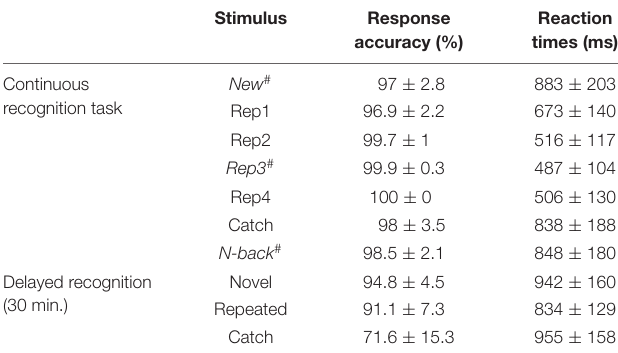
Percentage of correct responses and reaction times (ms) across different conditions in the continuous recognition task and the delayed recognition task. # Indicates the 3 trial types of interest for the evoked potential